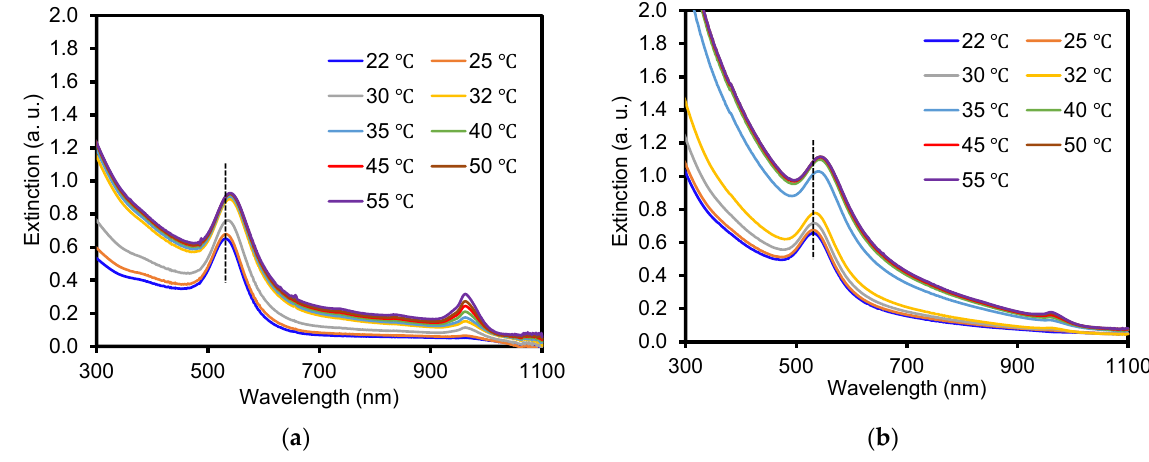
Figure 3. Absorption (i.e., SPR) patterns of composite particles prepared with ( a ) crosslinker-free and ( b ) crosslinked PNIPAM as a function of temperature (peak at ~970 nm is